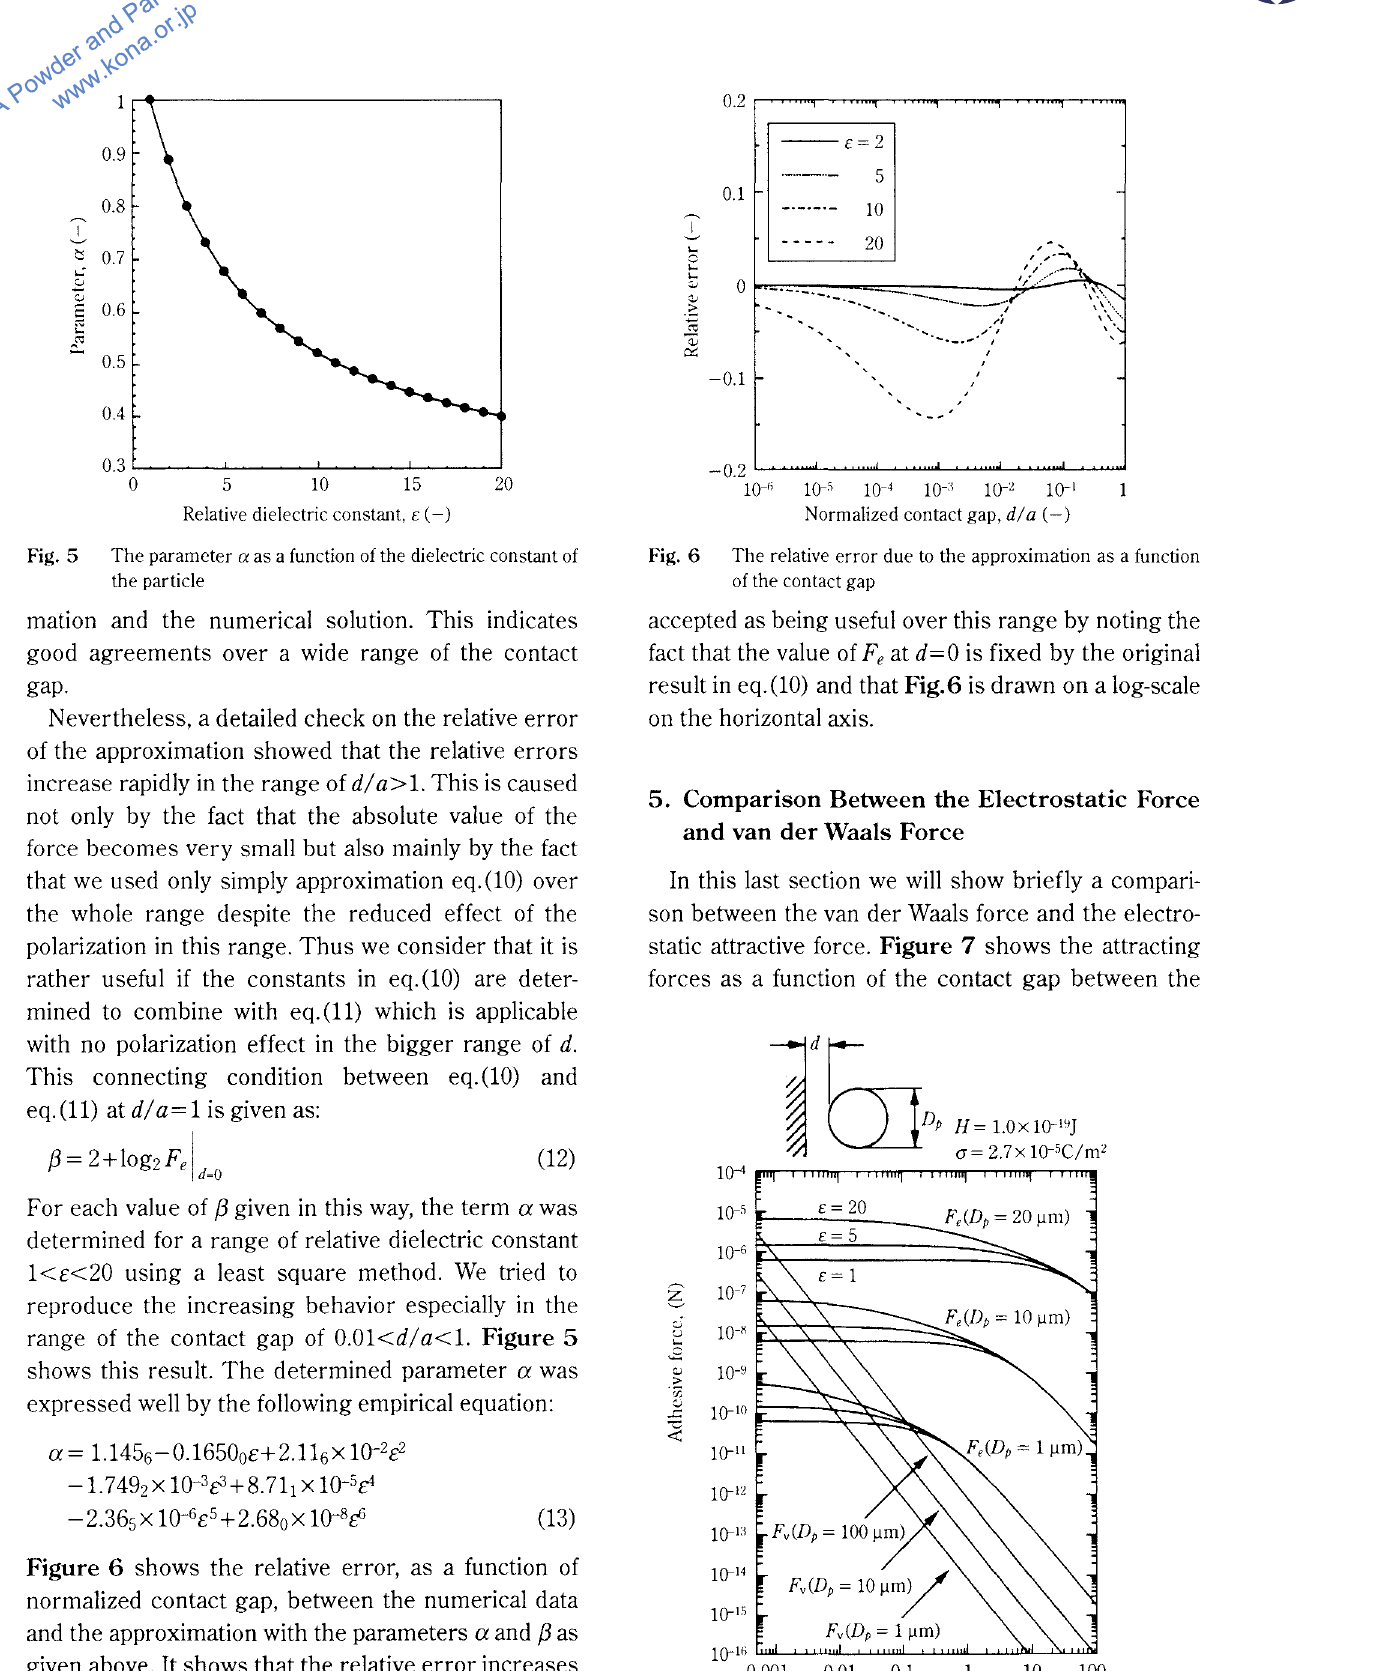
Fig. 7 Examples of comparisons between the van der Waals forces and the strict electrostatic